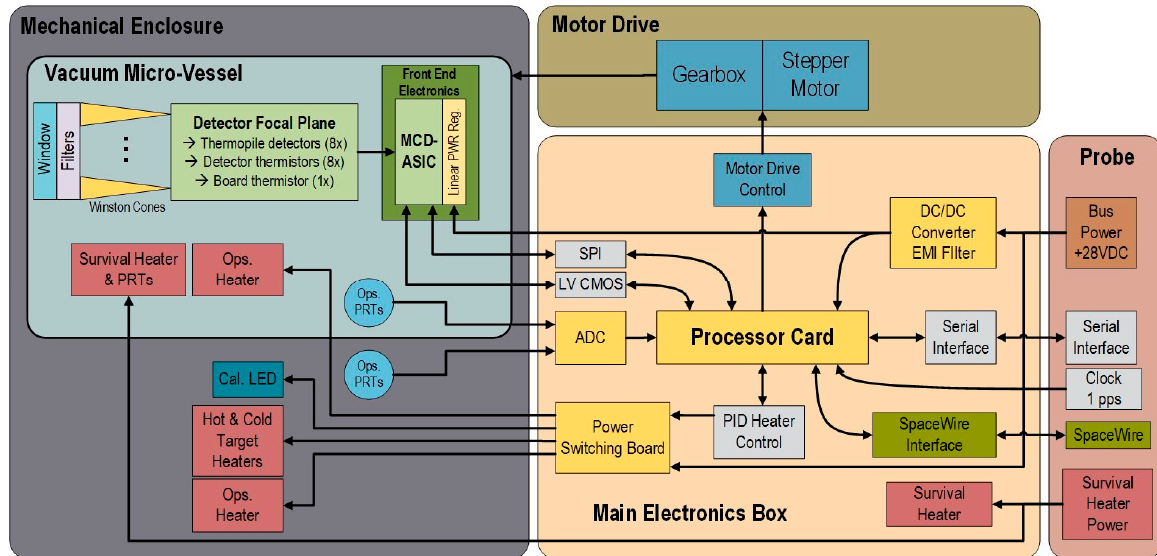
Figure 2. System block diagram. The CRC error check will run on the processor card shown in the main electronics box.